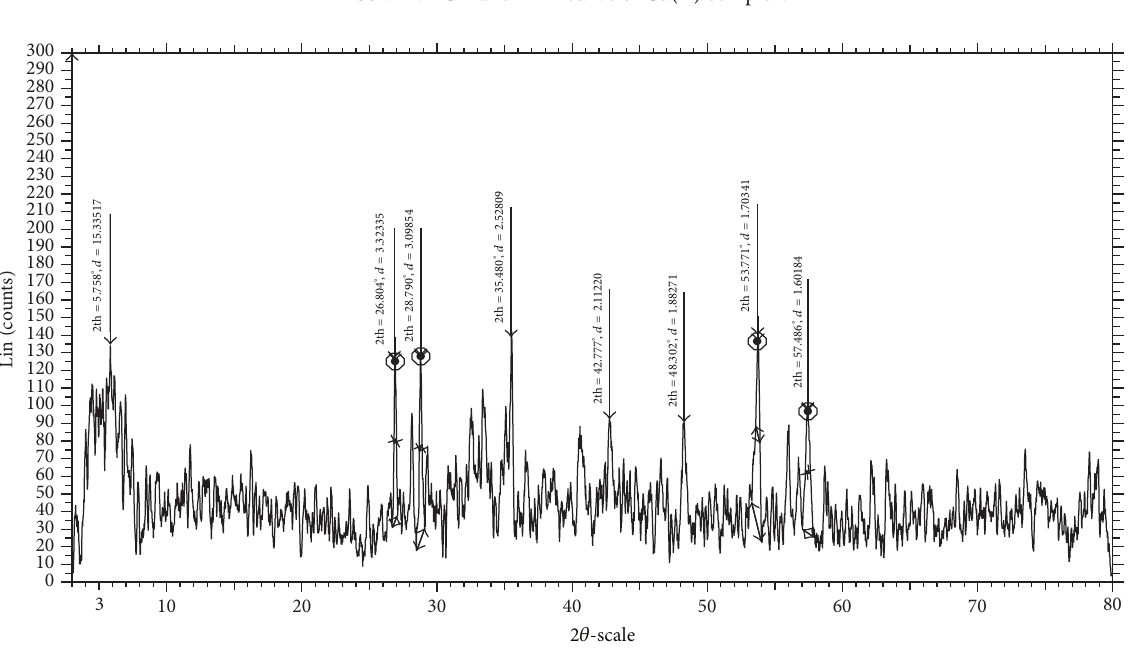
Figure 5: Powder XRD spectrum of Cu(II)